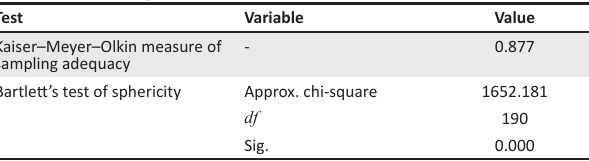
TABLE 2: Kaiser–Meyer–Olkin and Bartlett’s